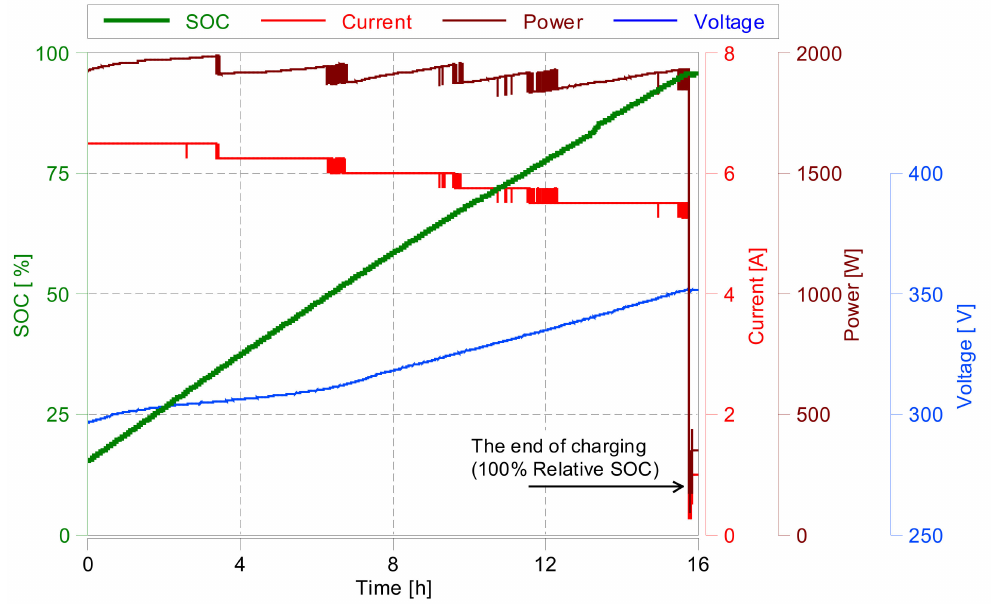
Figure 9. Single cycle charging profile carried out by household dedicated converter in constant current (CC)